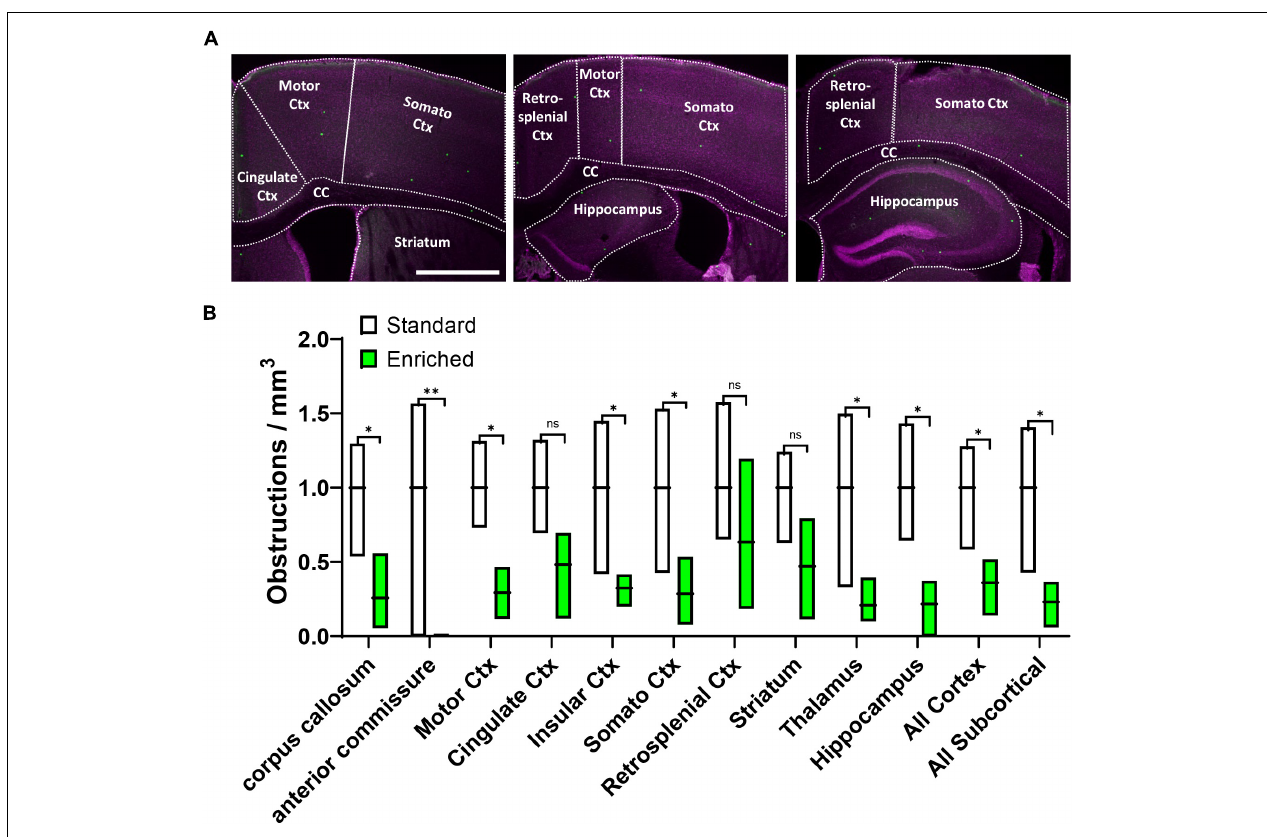
FIGURE 2 | Environmental enrichment generally improves recanalization across different brain regions. (A) Confocal images showing different brain regions outlined for analysis. (B) Box plot shows the obstruction density across different brain regions in aged mice exposed to standard or enriched cages. Note that striatum, thalamus, and hippocampus comprised the “All Subcortical” group. n.s. = not significant, ∗ p < 0.5, ∗∗ p < 0.01. Scale bar = 1 mm.